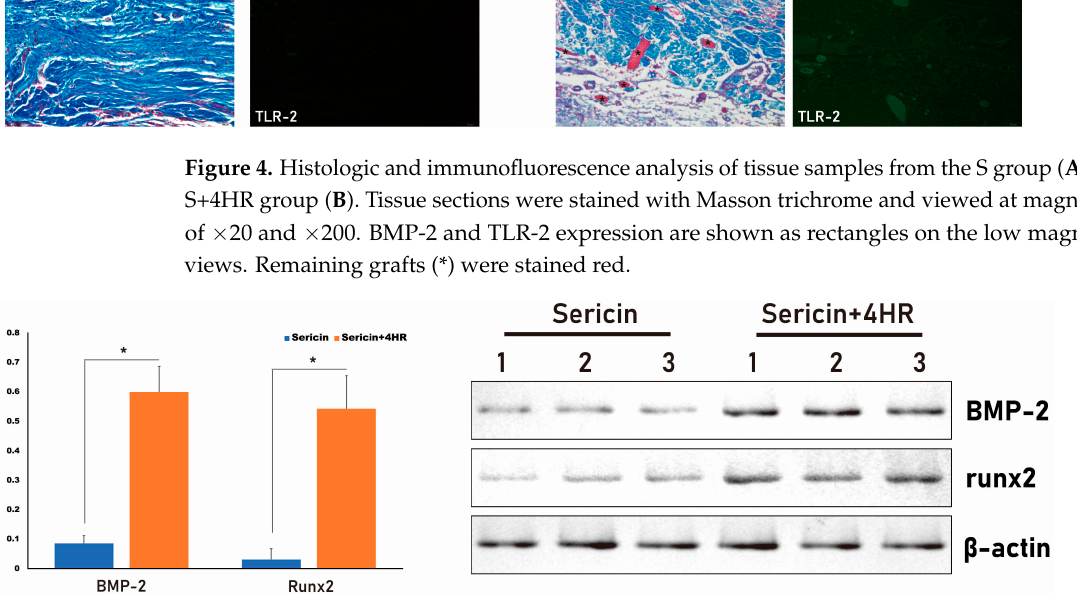
Figure 4. Histologic and immunofluorescence analysis of tissue samples from the S group ( A ) and the S+4HR group ( B ). Tissue sections were stained with Masson trichrome and viewed at magnifi- cations of ×20 and ×200. BMP-2 and TLR-2 expression are shown as rectangles on the low magnifi- cation views. Remaining grafts (*) were stained red.